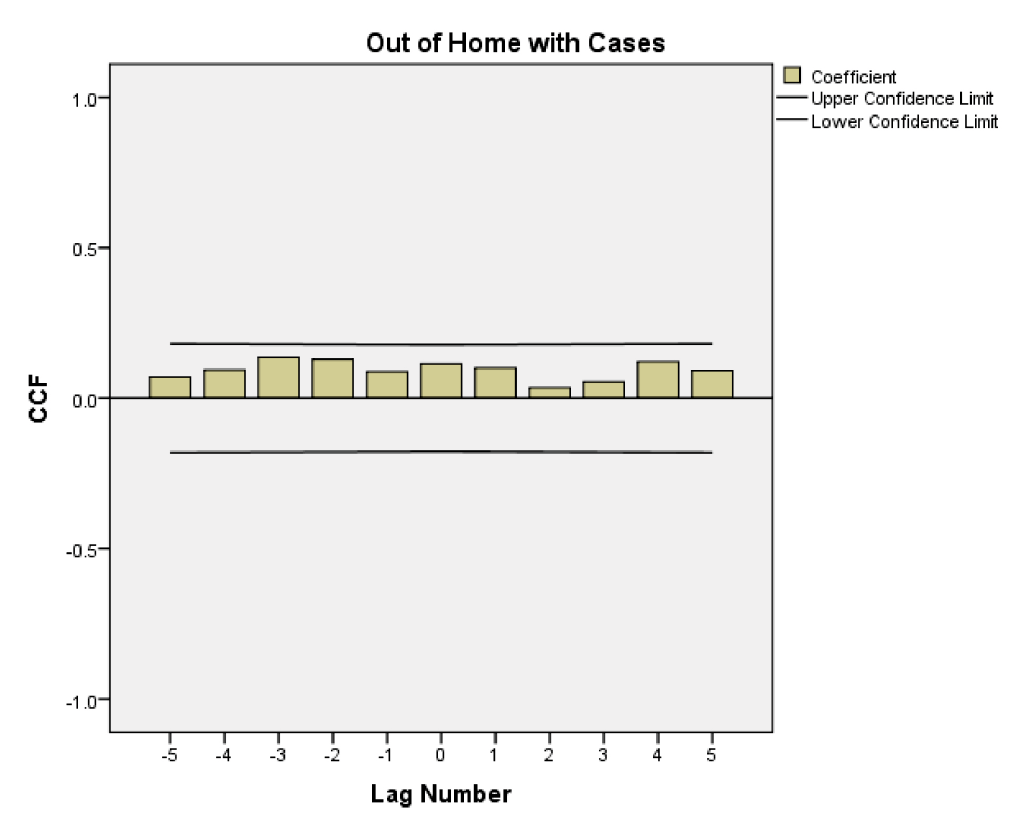
Figure 5: Cross Correlation Coefficients for OHL and